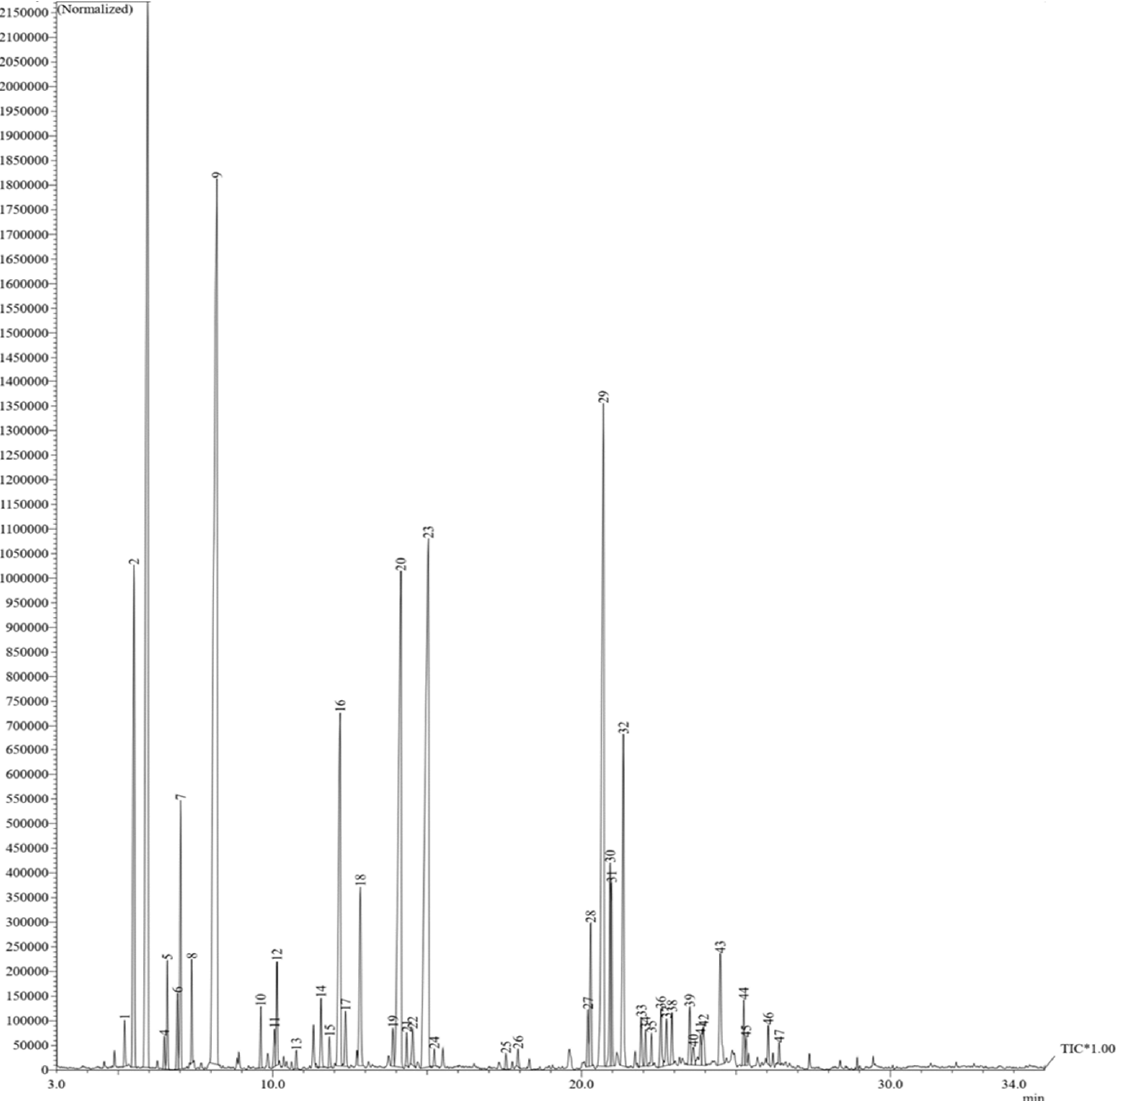
Figure 1. Typical chromatogram of total ion current plot of essential oil isolated from the rhizomes of ginger obtained by GC\GC–MS analysis.